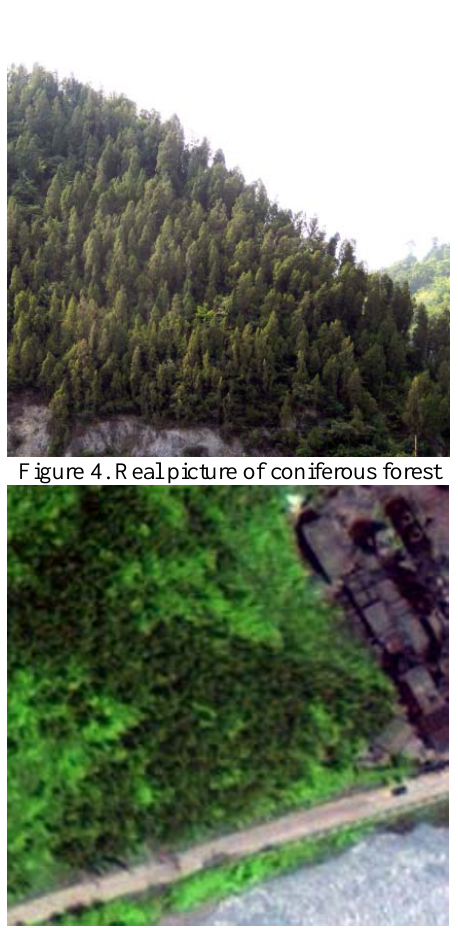
Figure 5. Image example of coniferous forest